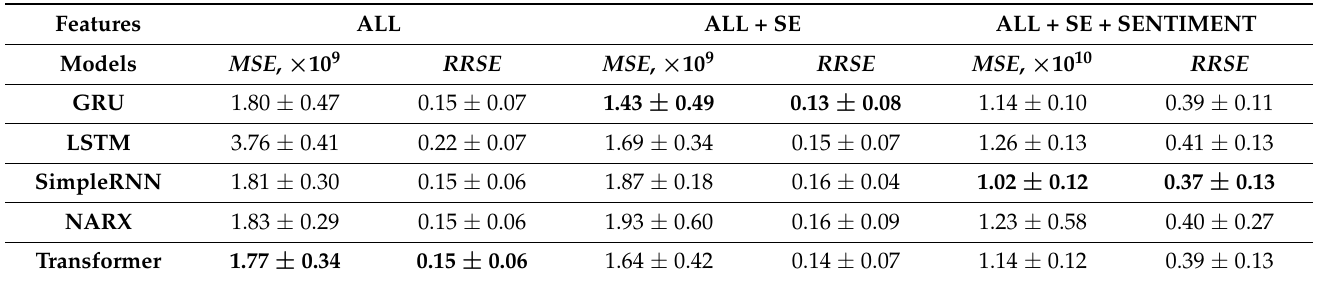
Table 6. Production prediction scores (regularization and sentiment